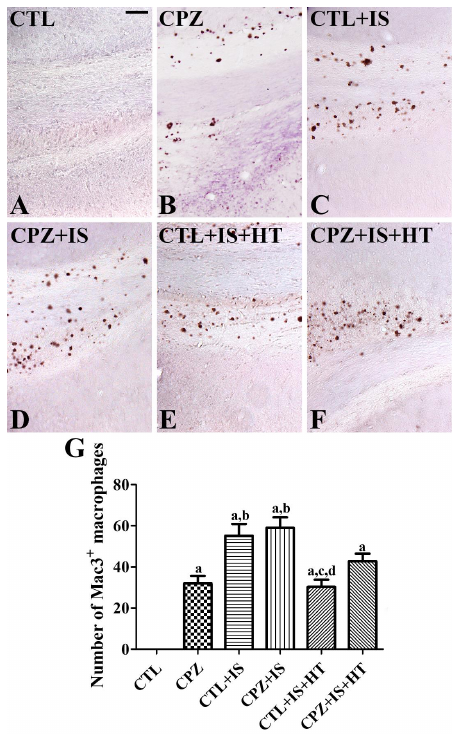
Figure 5. Mac3 immunohistochemistry in the gerbil subcallosal zone of the CTL ( A ), CPZ ( B ), CTL + IS ( C ), CPZ + IS ( D ), CTL + IS + HT ( E ), and CPZ + IS + HT ( F ) groups. Mac3-immunoreactive macrophages were mainly observed in the subcallosal zone after CPZ treatment and/or ischemic damage. Mac3-immunoreactive macrophages were most abundant in the CPZ + IS group and lowest in the CPZ or CTL + IS + HT group. Scale bar = 50 μM. ( G ) The number of Mac3-immunoreactive macrophages per section in each group is shown ( n = 5 per group, a p < 0.05, significantly different from the CTL group; b p < 0.05, significantly different from the CPZ group; c p < 0.05, significantly different from the CTL + IS group; d p < 0.05, significantly different from the CPZ + IS group). Error bars indicate standard deviation.